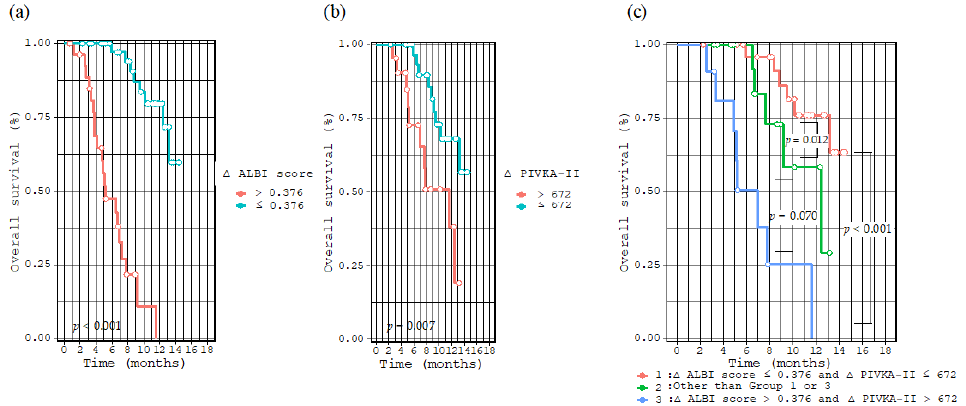
Figure 2. Kaplan– Meier curve for overall survival divided by ∆ ALBI score of 0.376 ( a ), ∆ PIVKA -II of 672 mAU/mL ( b ), and divided into three groups as follows: Group 1, patients with ∆ ALBI score ≤0.376 and ∆ PIVKA - II ≤672 mAU/mL; Group 3, patients with ∆ ALBI score >0.376 and ∆ PIVKA -II >672 mAU/mL; and Group 2, patients with others ( c